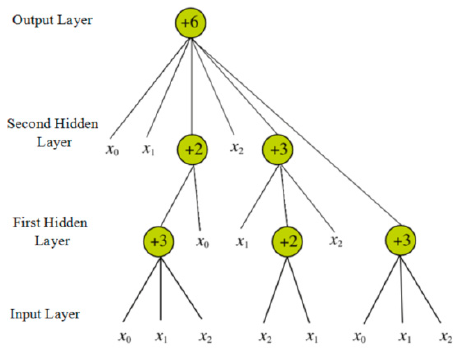
Figure 7. Typical structure of a flexible neural tree (FNT).